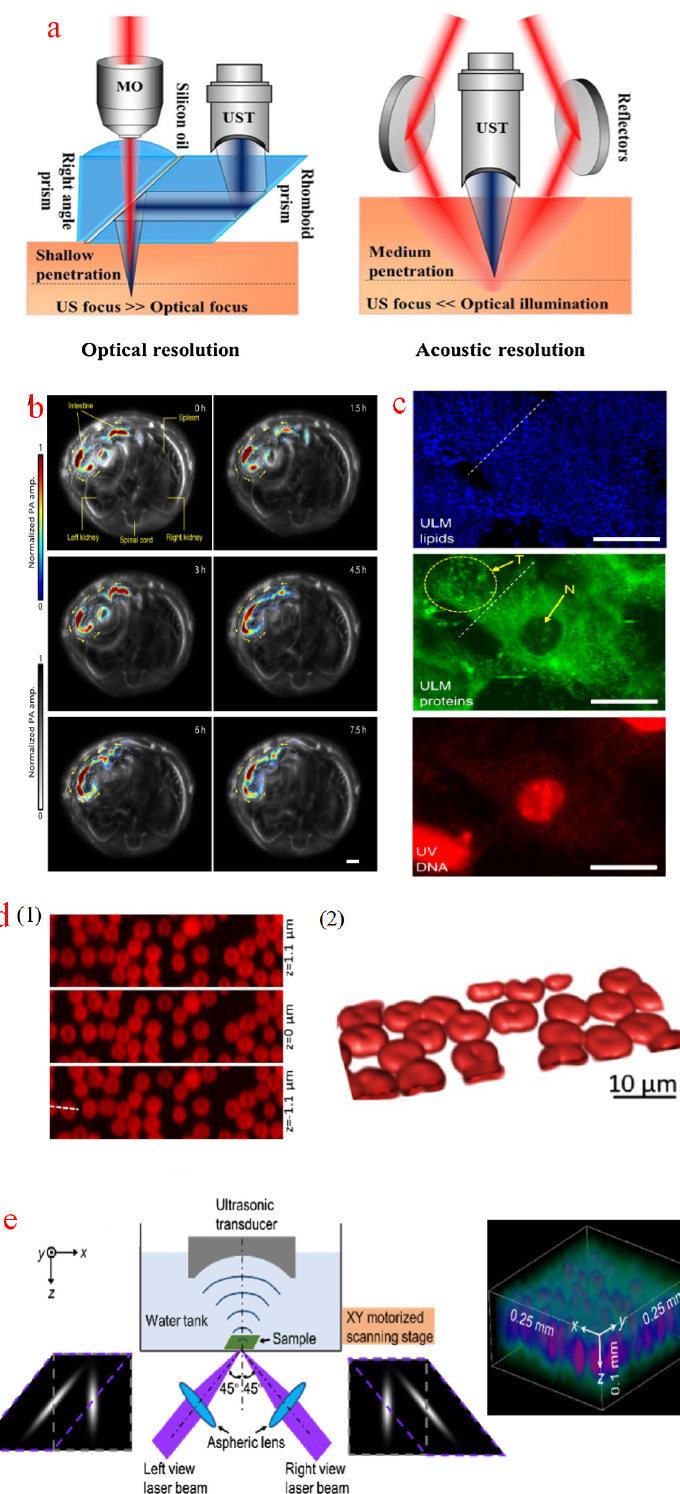
Figure 2. Photoacoustic imaging. ( a ) Two operation modes of PAM. Adapted with permission from Reference [86]; ( b ) Time-lapse PAM measurement of microrobot movement in the intestine. Microrobot migration is shown in color and the mouse tissues are displayed in gray. Adapted with permission from Reference [87]; ( c ) Ultraviolet-localized mid-infrared PAM sampled images of